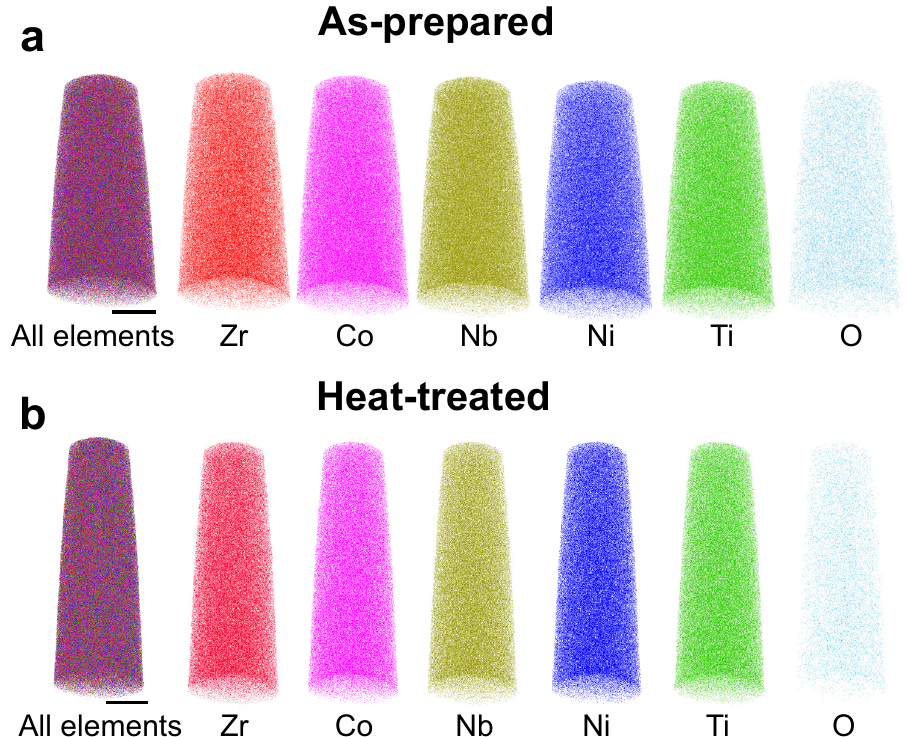
Fig. 2 APT analyses of the as-prepared and heat-treated samples. a The APT results of the as-prepared sample. b The APT results of the heat-treated sample. The results show no compositional heterogeneity. Scale bar: 20 nm. Additional APT results and quantitative analyses in Supplementary Note